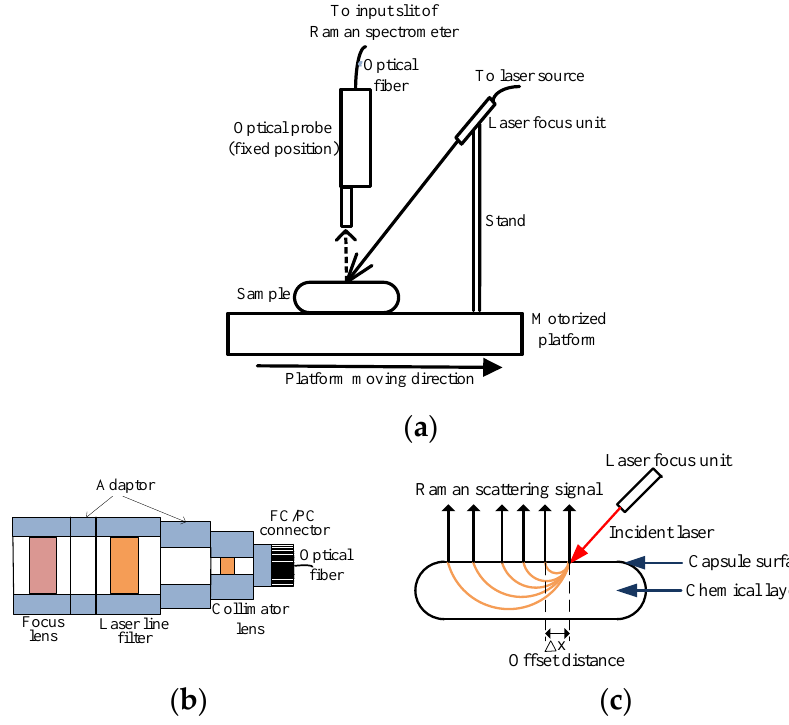
Figure 1. ( a ) Sample compartment for SORS data collection; ( b ) laser focus unit; and ( c ) SORS technique for detecting Raman scattering from sample